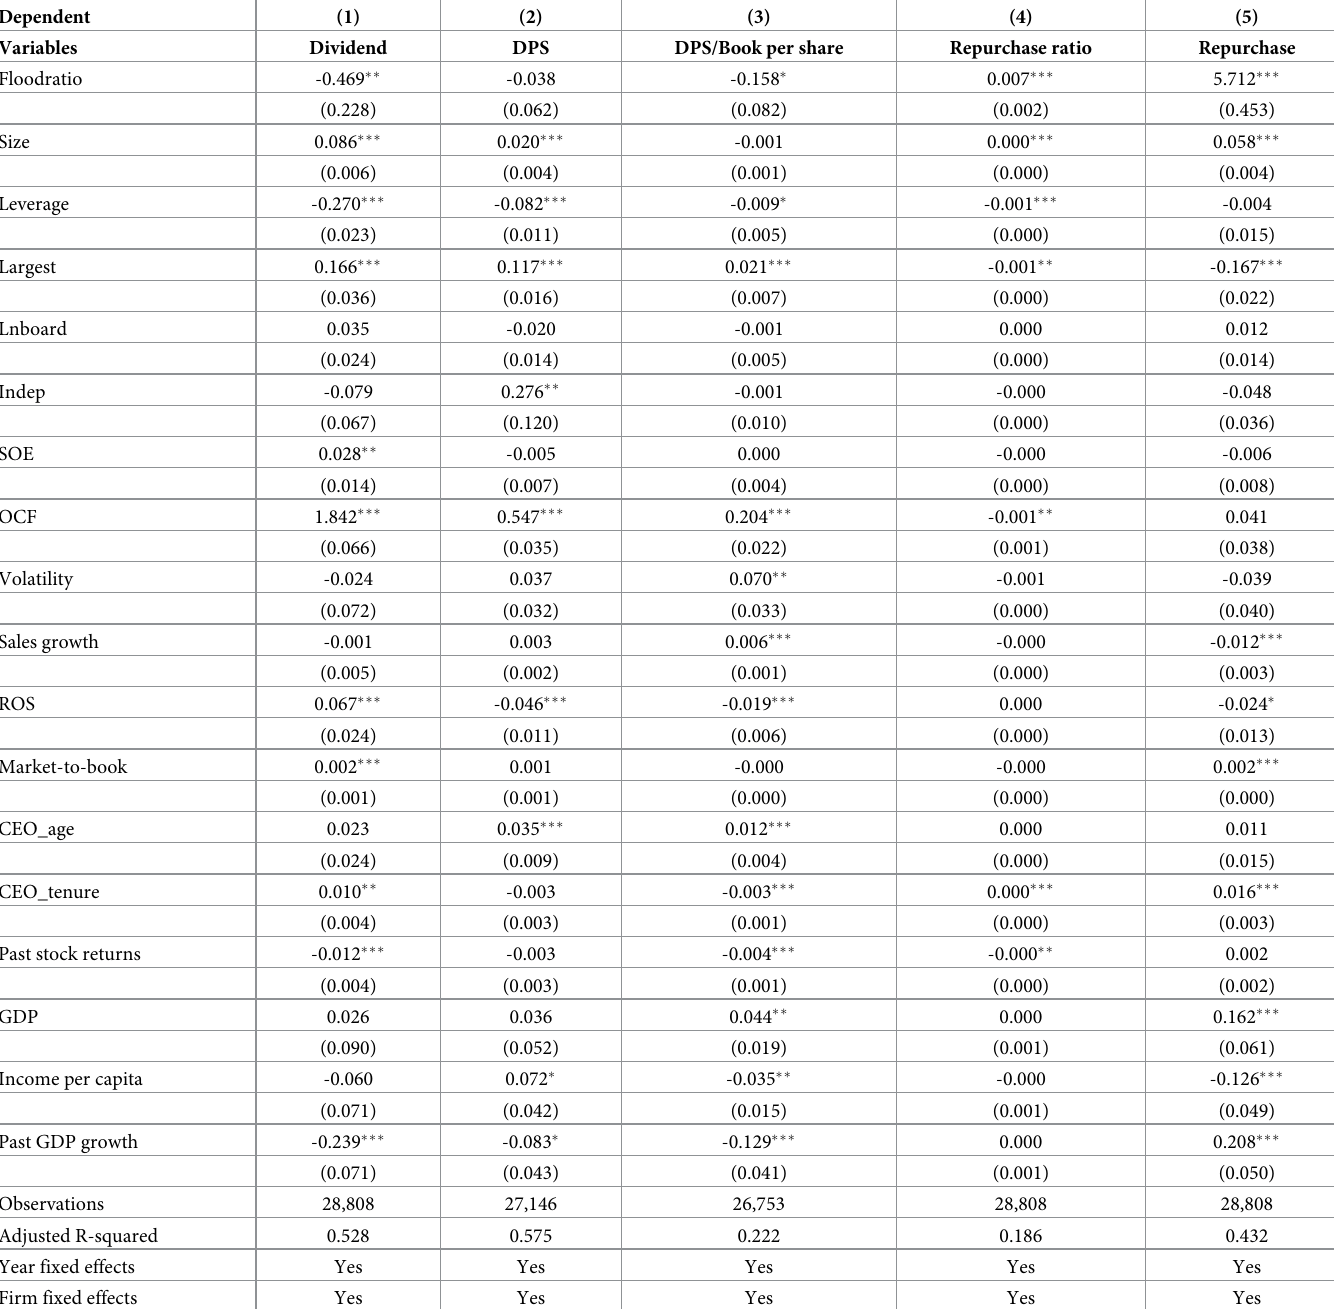
Table 8. Flooding and firm payout policy. This table reports the regression results of the effects of flooding on firm payout policy. Dependent variables are the probabil- ity of paying cash dividends ( Dividend ) in column 1, dividend per share ( DPS ) in column 2, DPS to book value of equity per share ( DPS/Book per share ) in column 3, repurchase payment to market value of equity ( Repurchase ratio ) in column 4, and probability of repurchase ( Repurchase ) in column 5, respectively. Variable definitions are in Table A1 in the S1 Appendix. Robust standard errors are clustered at the city-year level and reported in parentheses. � , �� and ��� indicate the significance levels at 10%, 5% and 1%,